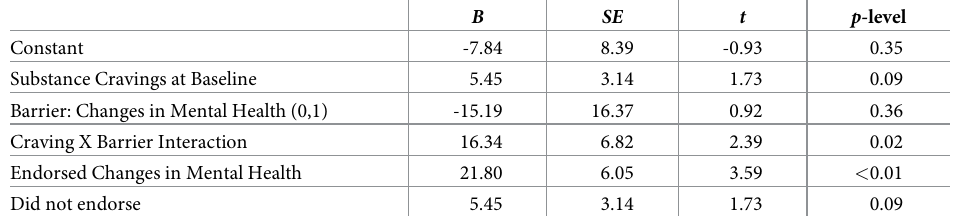
Table 4. Interaction between baseline substance cravings and changes in mental health to predict days using sub- stances at follow-up.